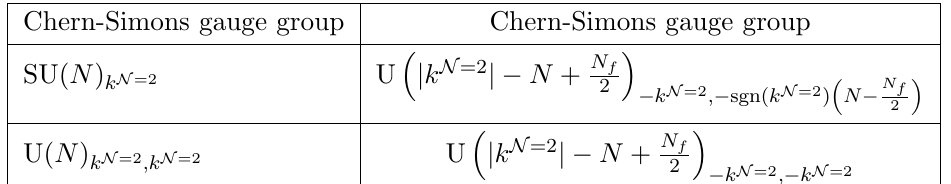
2 k N =2 and for positive ranks on both (cid:20) j j